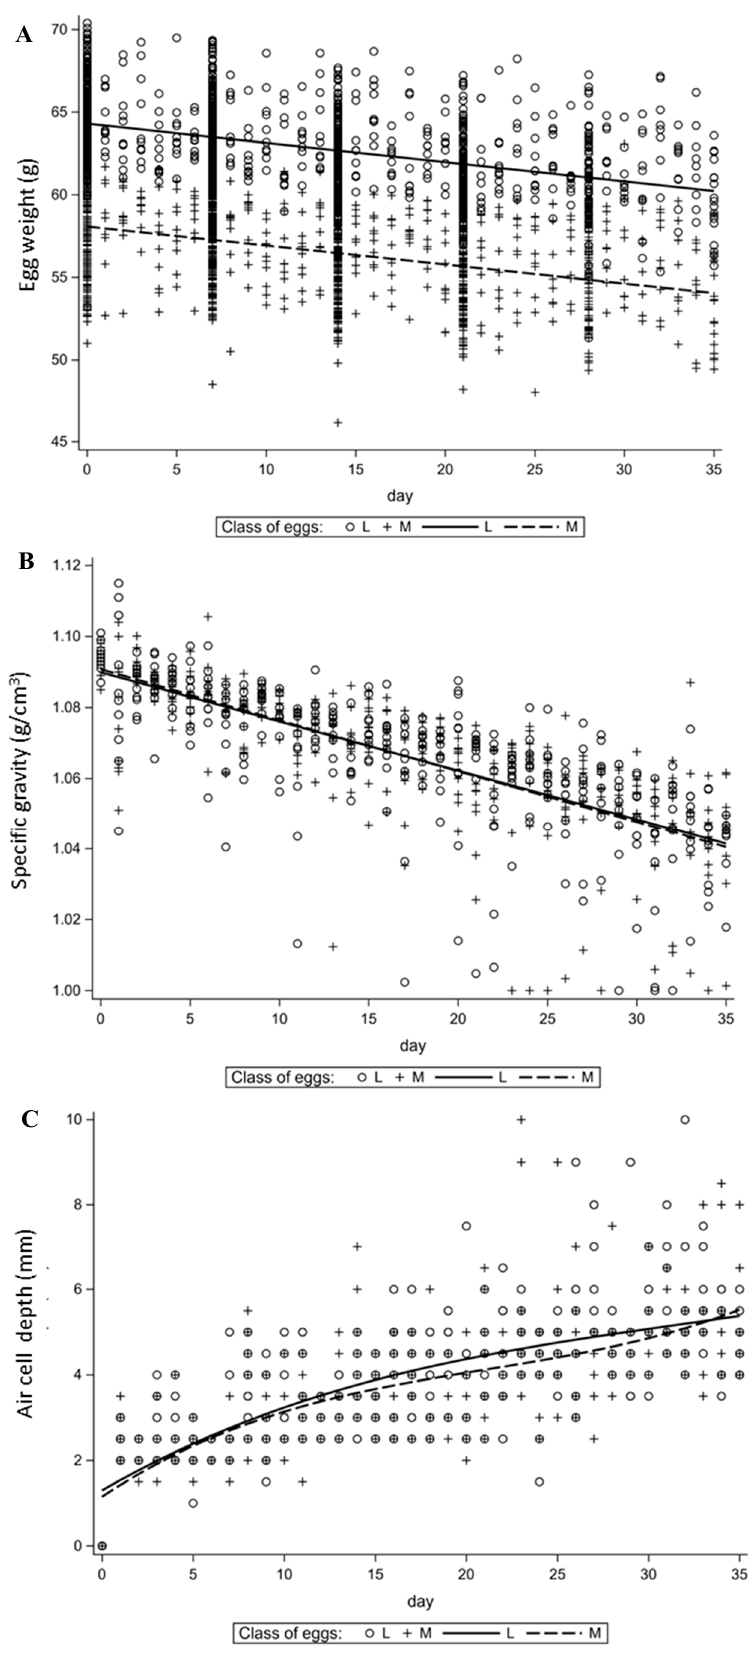
Figure 1. Changes in time of selected traits of whole egg. ( A )—egg weight (EW), ( B )—specific gravity (SG), ( C )—air cell depth (ACD).